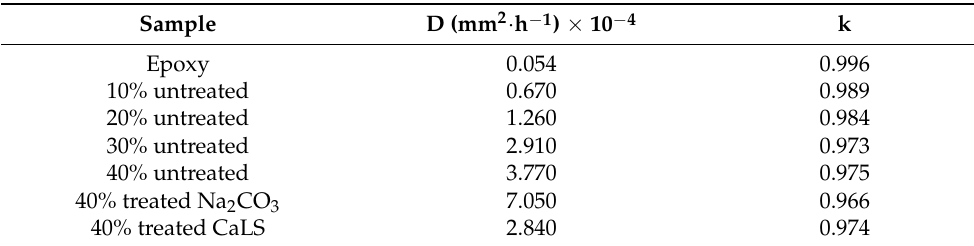
Figure 9. Diffusion coefficient values for composite samples. Table 2. Water absorption for untreated and treated TVF composites. Diffusion coefficient D and parameter k.